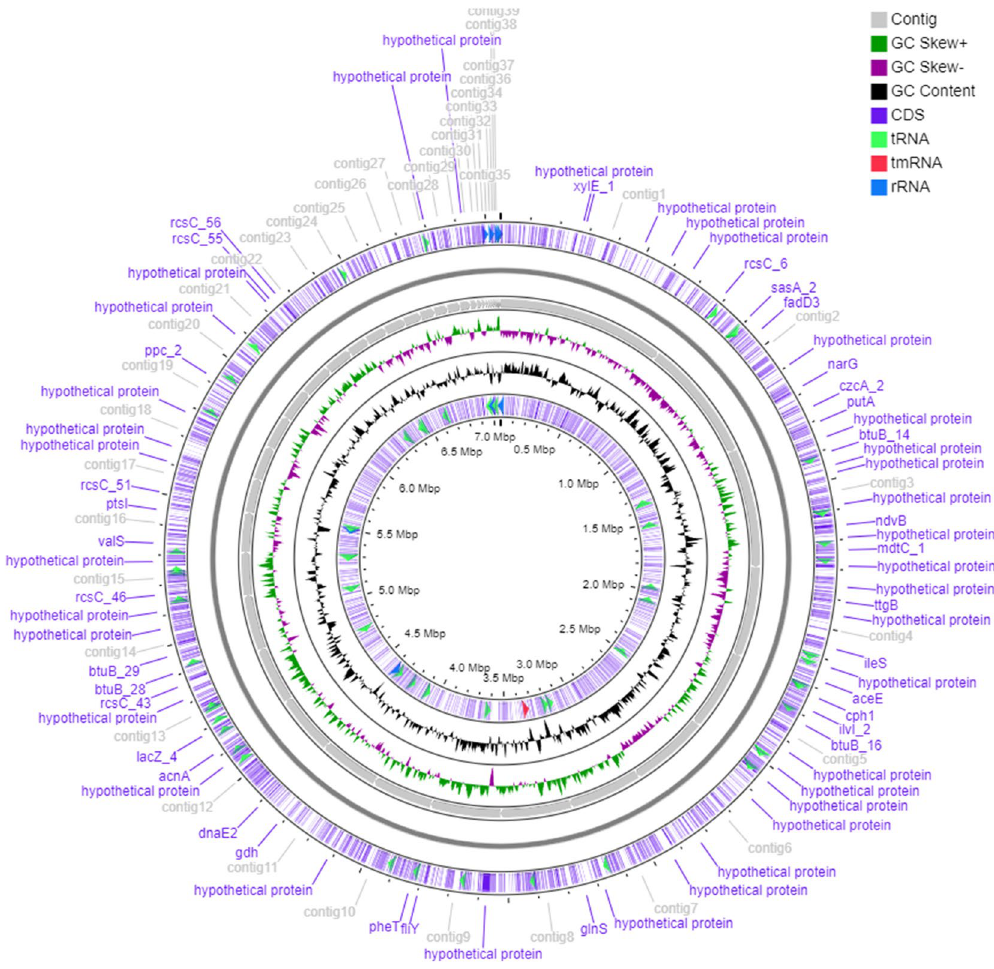
Figure 2. Graphical genomic map of strain TW-1 T